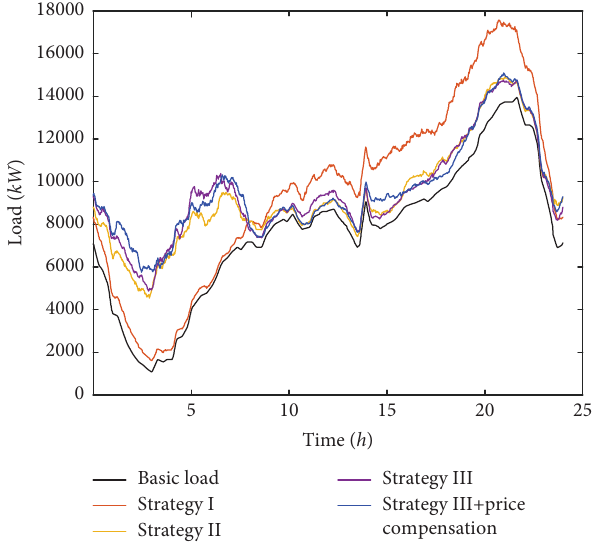
Figure 6: Grid load curve under diferent DR